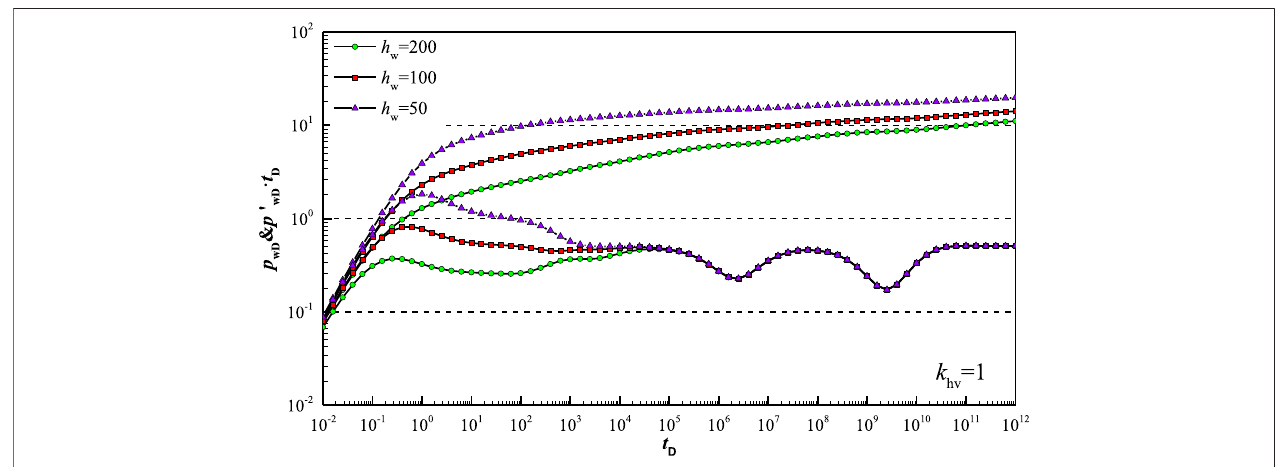
FIGURE 8 | Type curve affected by length of inclined well ( C D (cid:2) 0 . 1 , S (cid:2) 0 . 1 , h (cid:2) 100 , r w (cid:2) 0 . 1 , θ w (cid:2) 60 o , k hv (cid:2) 1 , k D (cid:2) 1 , κ (cid:2) 0 . 7 , ω f (cid:2) 0 . 01 , ω V (cid:2) 0 . 1 , λ mf (cid:2) 10 − 12 , λ